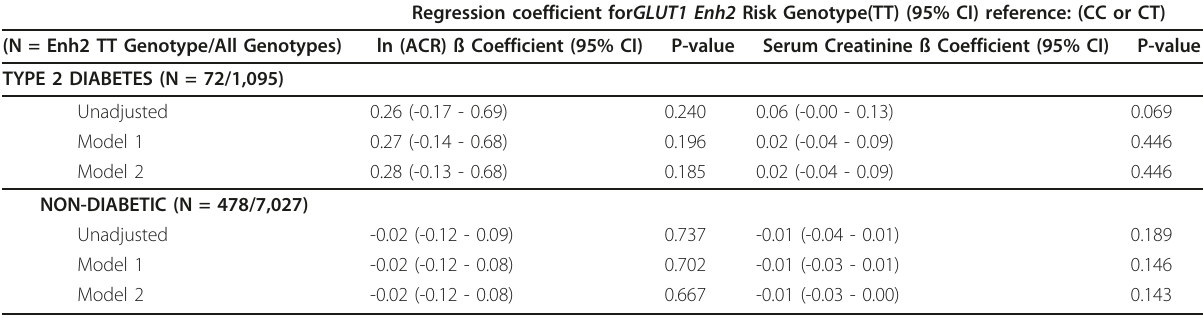
Table 5 Unadjusted and multivariate linear regression of ln (ACR) and serum creatinine for Enh 2 in all genotyped European Americans, by type 2 diabetes